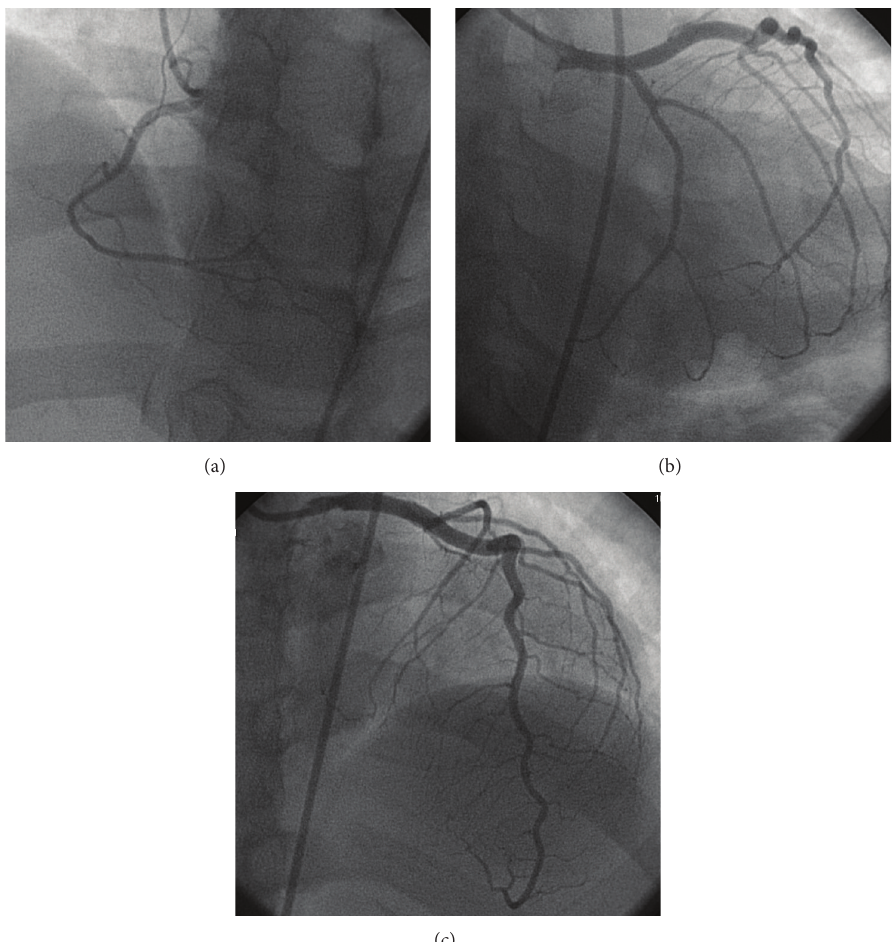
Figure 3: (a) Normal RCA is observed. (b) Normal LAD and left circumflex arteries are observed. (c) Normal LAD is observed.